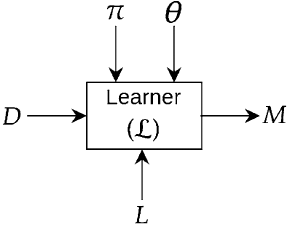
Figure 4. Construction of a deep model M from data ( D ) using a learner ( L ). We use π to denote the structure (organisation of various layers, their interconnections etc.) and θ to denote the parameters (synaptic weights) of the deep network. L denotes the loss function (for example, cross-entropy loss in case of classification).